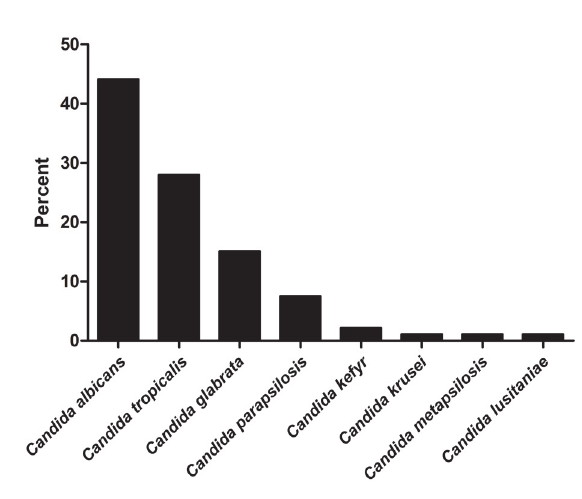
Figure 1 - Percentage of species identified by MALDI-TOF mass spectrometry. C. albicans (44.1%), C. tropicalis (28%), C. glabrata (15.1%), C. parapsilosis (7.5%), C. kefyr (2.2%), C. krusei (1.1%), C. metapsilosis (1.1%), C. lusitaniae (1.1%).